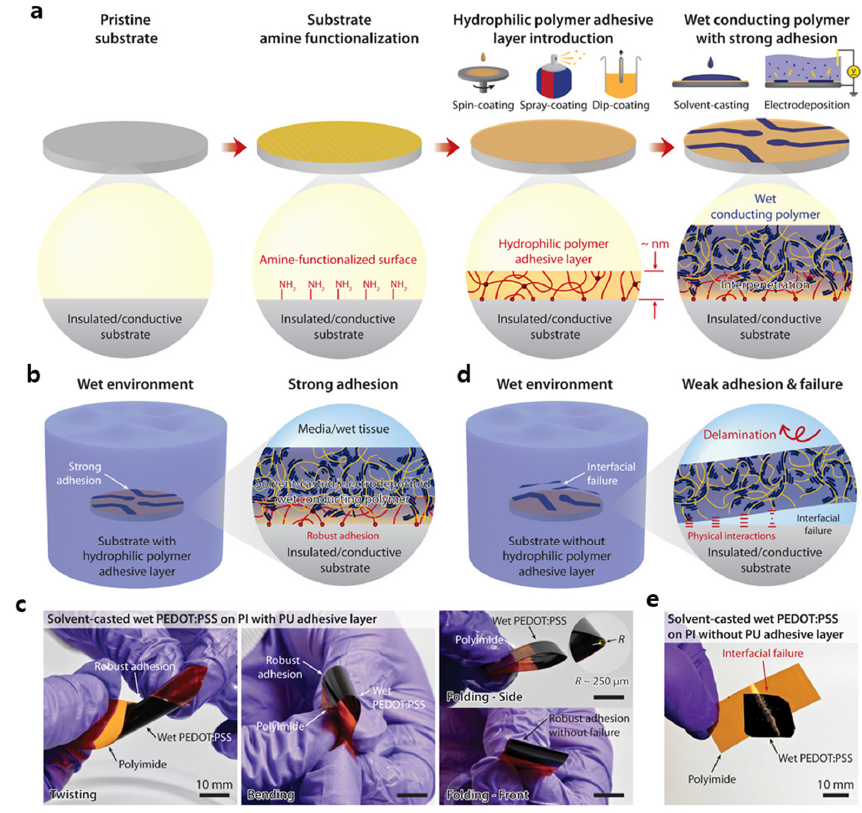
Figure 2. Strong adhesion of CP on different substrates. ( a ) An amine-functionalized substrate with a hydrophilic polymer adhesive layer, ( b ) A substrate with an adhesive layer in a wet environment, ( c ) A polyimide substrate with a polyurethane adhesive layer, ( d ) Weak and unstable adhesion without the adhesive layer, and ( e ) A polyimide substrate without the adhesive layer (Reproduced with permission from ref [134]).